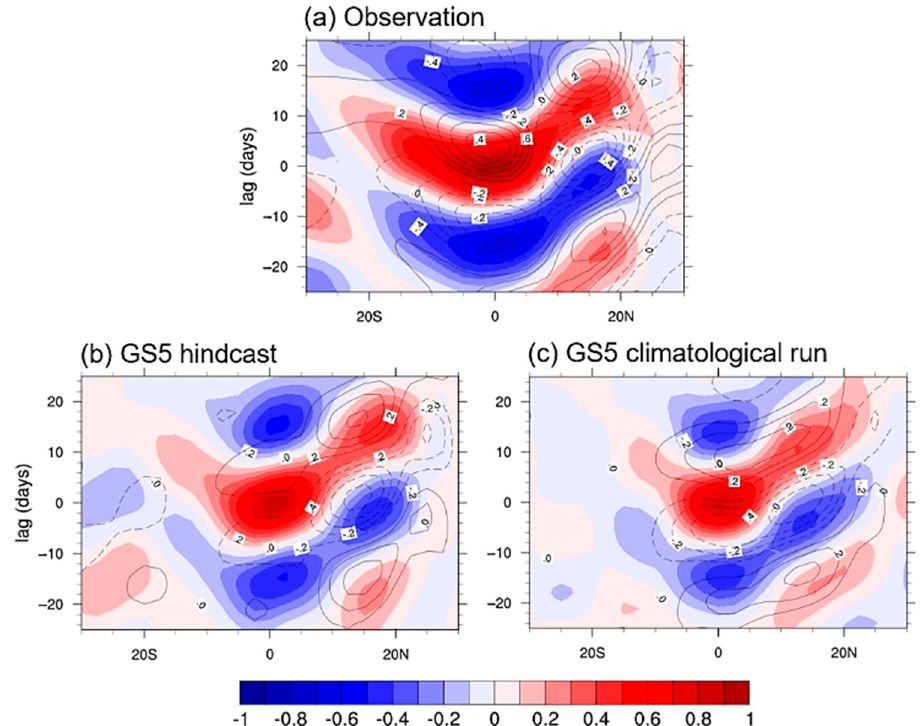
Figure 10. Lagged correlation of 20–70 days filtered precipitation (zonal wind at 850 hPa) averaged over 80°–100° E from ( a ) observation, ( b ) the GS5 hindcast, and ( c ) the GS5 climatological run during boreal summer (May–October). The intraseasonal oscillation (ISO) precipitation averaged over 80° E–100° E and 5° S–5° N was used as a reference for calculating the correlation. The shading shows precipitation, and the contour is the zonal wind at 850 hPa.